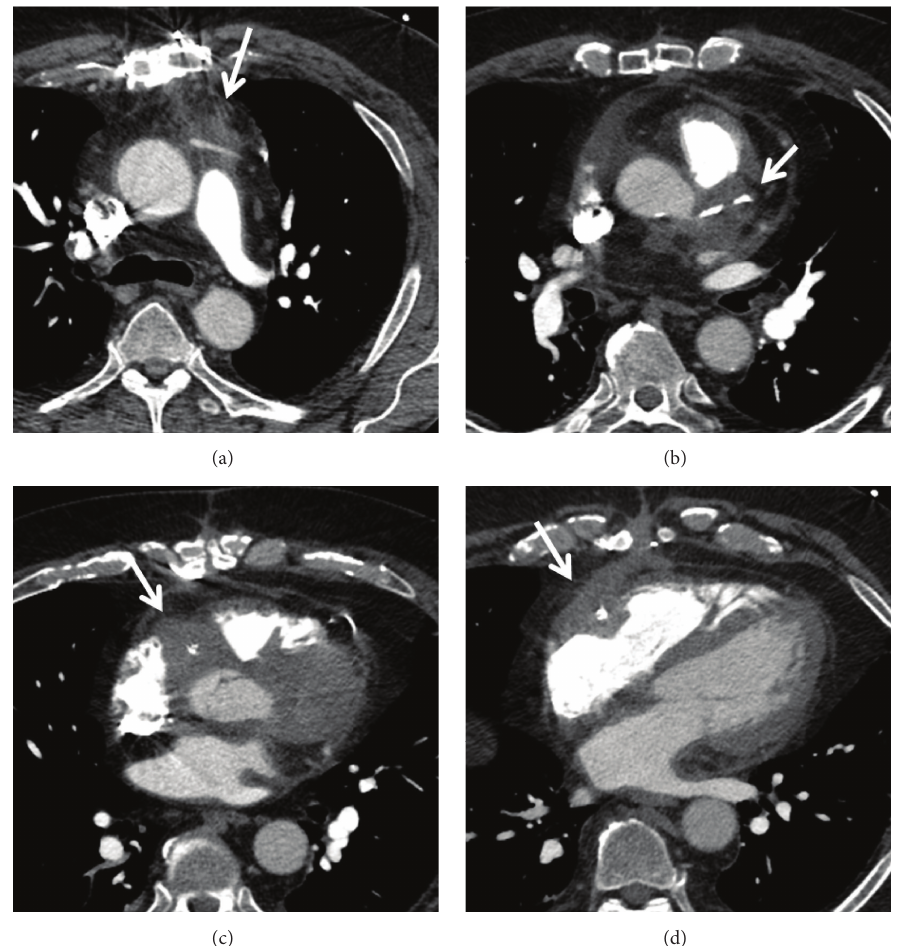
Figure 1: Contrast-enhanced computed tomography shows subsequent images through heart in the patient with granulomatosis with polyangiitis, extensive soft tissue attenuation around the coronary artery graft (a), left main coronary artery (b), and right coronary artery (c, d).